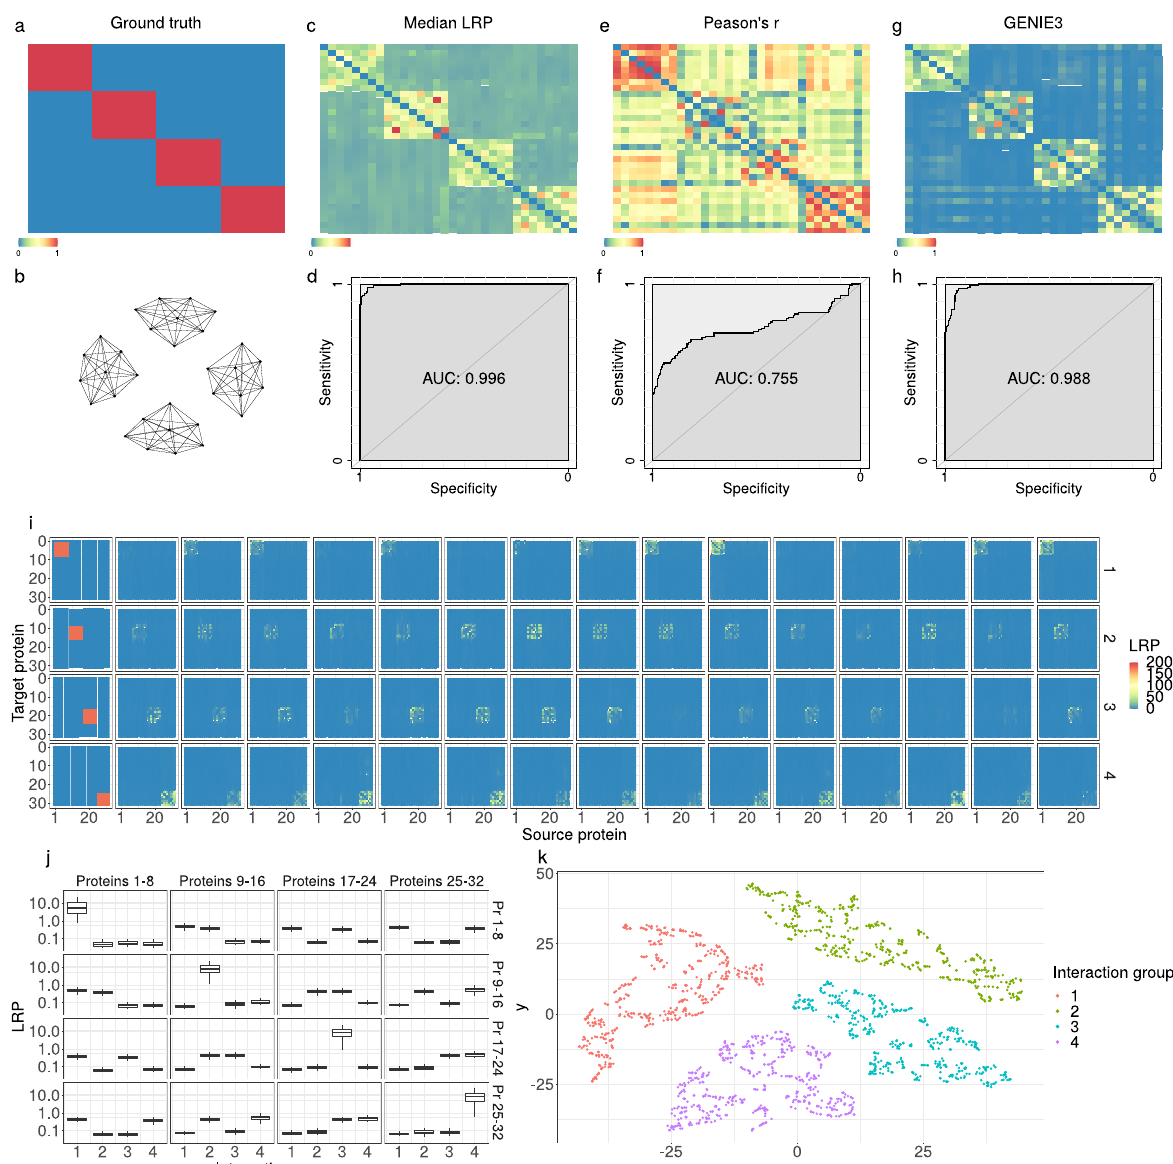
Fig. 3 Network reconstruction on synthetic data. Synthetic data SD1: Interactions were de fi ned only between proteins that are members of the same group of eight proteins. The existence or absence of interactions between two proteins can be represented with an interaction graph ( b ) or, alternatively, as entries of an adjacency matrix ( a ) that are set to one if two proteins interact and to zero if they do not. c – h Reconstructed interactions (top) and respective ROC analyses (bottom). LRP au ( c , d ) and GENIE3 ( g , h ) can reconstruct the interaction graph almost perfectly and clearly outperform Pearson ’ s r ( e , f ). Synthetic data SD2: i Reconstruction of protein interactions for individual samples of data set SD2 with LRP au . In each sample, only members of one of four protein groups interacted with each other while all other proteins had no interactions. The fi rst column illustrates a ground truth interaction network (visualized as adjacency matrix), while all further panels of the row represent the LRP reconstruction of the interaction network for individual samples from this interaction group. Overall, interactions could be reconstructed with an AUC of 0.934. j Each subplot shows the averaged strength of predicted interactions between the different protein groups (logarithmic scale). Median is indicated by center line, bounds of boxes indicate interquartile range, and whiskers extend to a maximum distance of 1.5 ⋅ IQR from the hinge. High values were found speci fi cally between proteins of the same group (on the diagonal) and only if the interaction group to which the sample belonged, permitted interactions in this set of proteins. k t-SNE analysis of samples according to their reconstructed interactions. Each point represents one sample, and colors indicate the four different interaction groups. Samples that had the same interactions are separable from other